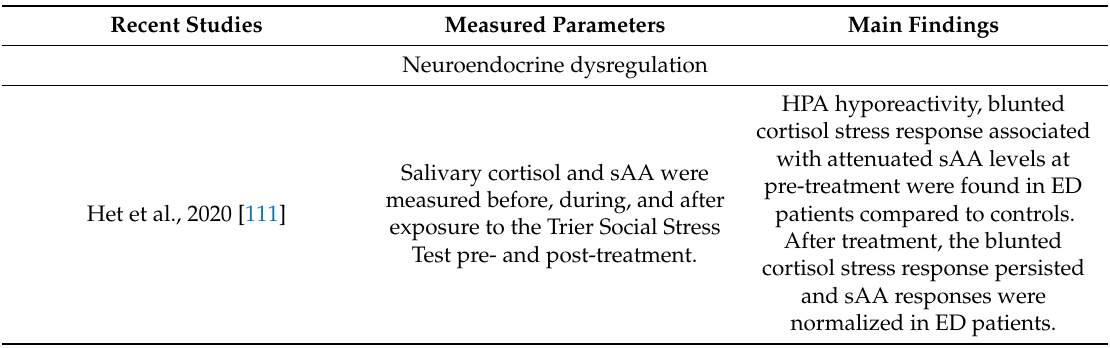
Table 1. Recent studies of neuroendocrine, immune, and autonomic nervous system dysregulation in anorexia